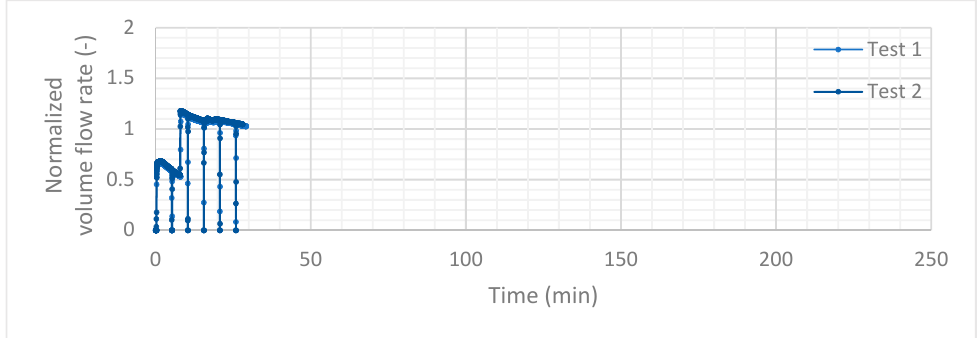
− 30 °C during the two repetitions. During one of the repetitions, the thermostatic temperature was